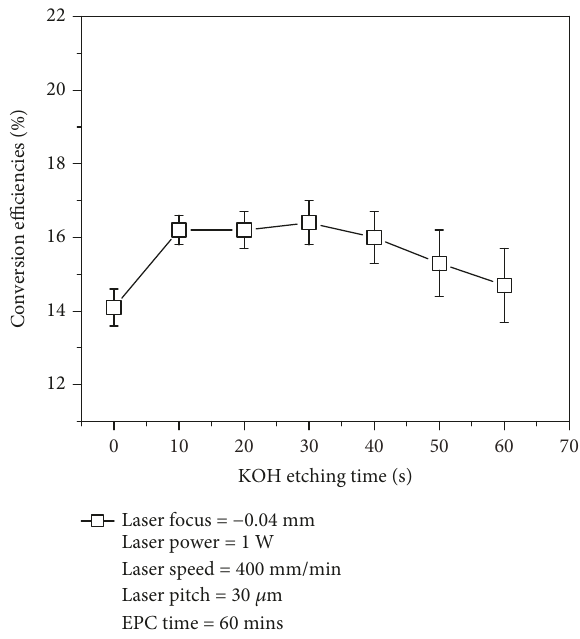
Figure 8: Conversion e ffi ciency vs. KOH etching time curve of SPMSCs with a B-BSF seed layer and EPC contact layer as the rear contacts.